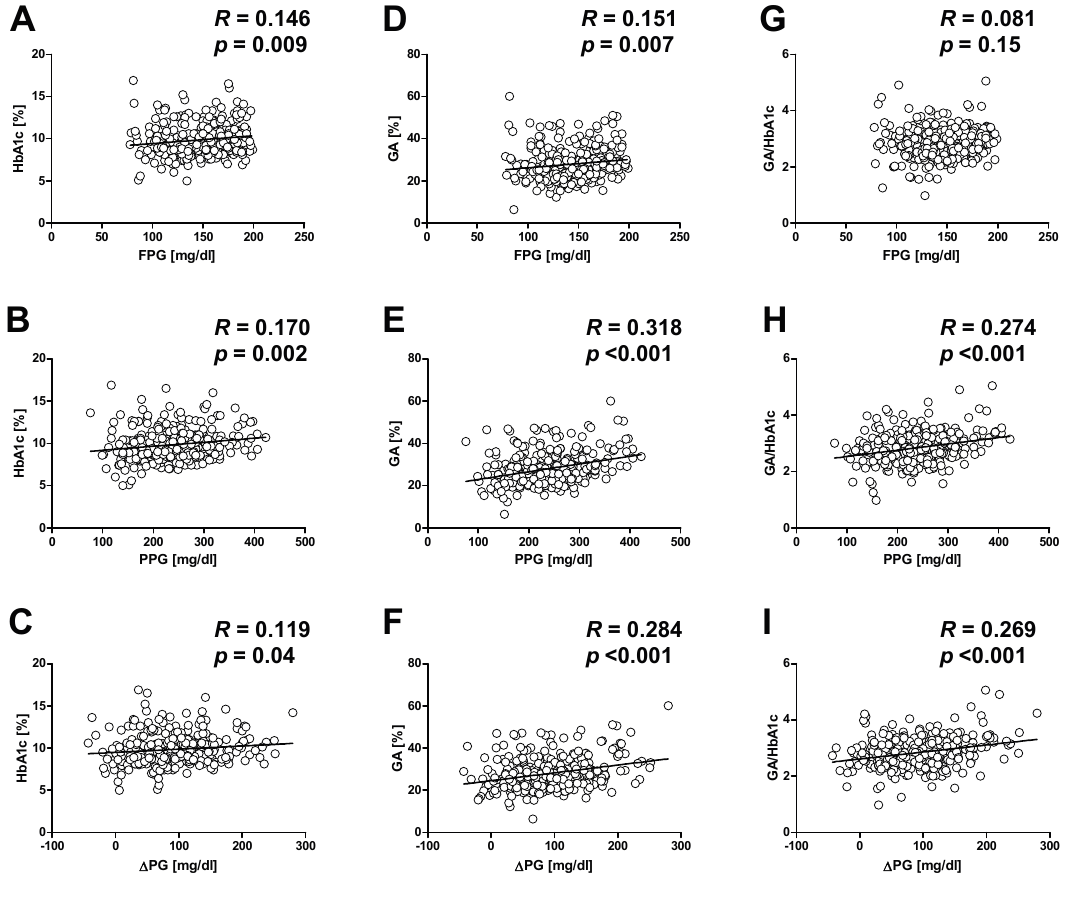
Figure 2. Correlations among HbA1c, glycated albumin (GA), GA/HbA1c ratio and other glycemic indices. HbA1c and GA were both significantly correlated with fasting plasma glucose (FPG) ( A , D ), postprandial plasma glucose (PPG) ( B , E ) and ∆ PG ( i.e. , PPG-FPG) ( C , F ), while GA was more strongly correlated with PPG and ∆ PG than was HbA1c. There was a significant positive correlation between PPG ( H ) and ∆ PG ( I ) and GA/HbA1c ratio, but no correlation between FPG and GA/HbA1c ratio ( G ). Reproduced with permission from the Japan Diabetes Society